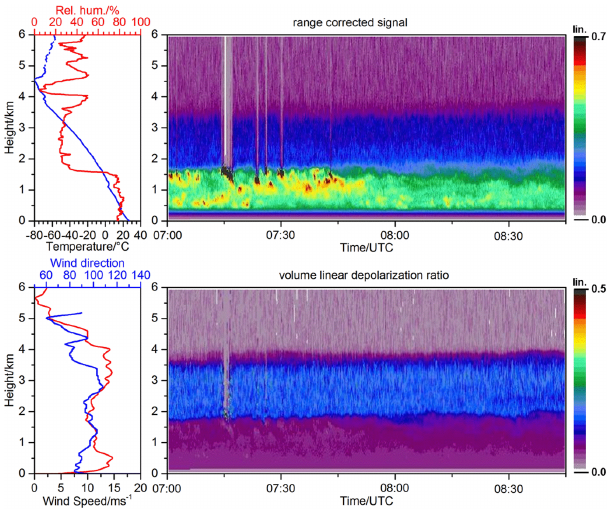
Figure 8. Same as Fig. 4 but for 1 July 2013, 07:00–08:45UTC. The radiosonde was launched on 1 July at 00:00UTC.